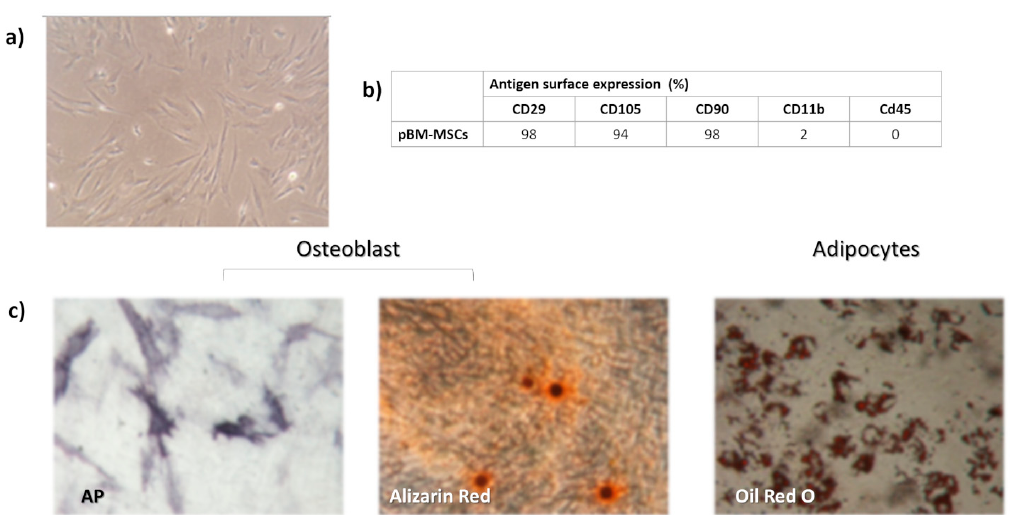
Figure 1. In vitro expanded porcine bone marrow mesenchymal stem cells (pBM-MSC) characterization: ( a ) typical spindle shape morphology of adherent p-MSC; ( b ) percentage of antigen surface expression of pBM-MSCs; and ( c ) osteogenic and adipogenic differentiation capacity after in vitro induction with specific stimuli. Magnification 4× ( a ), 10 and 20× osteoblast and adipocytes, respectively ( c ).